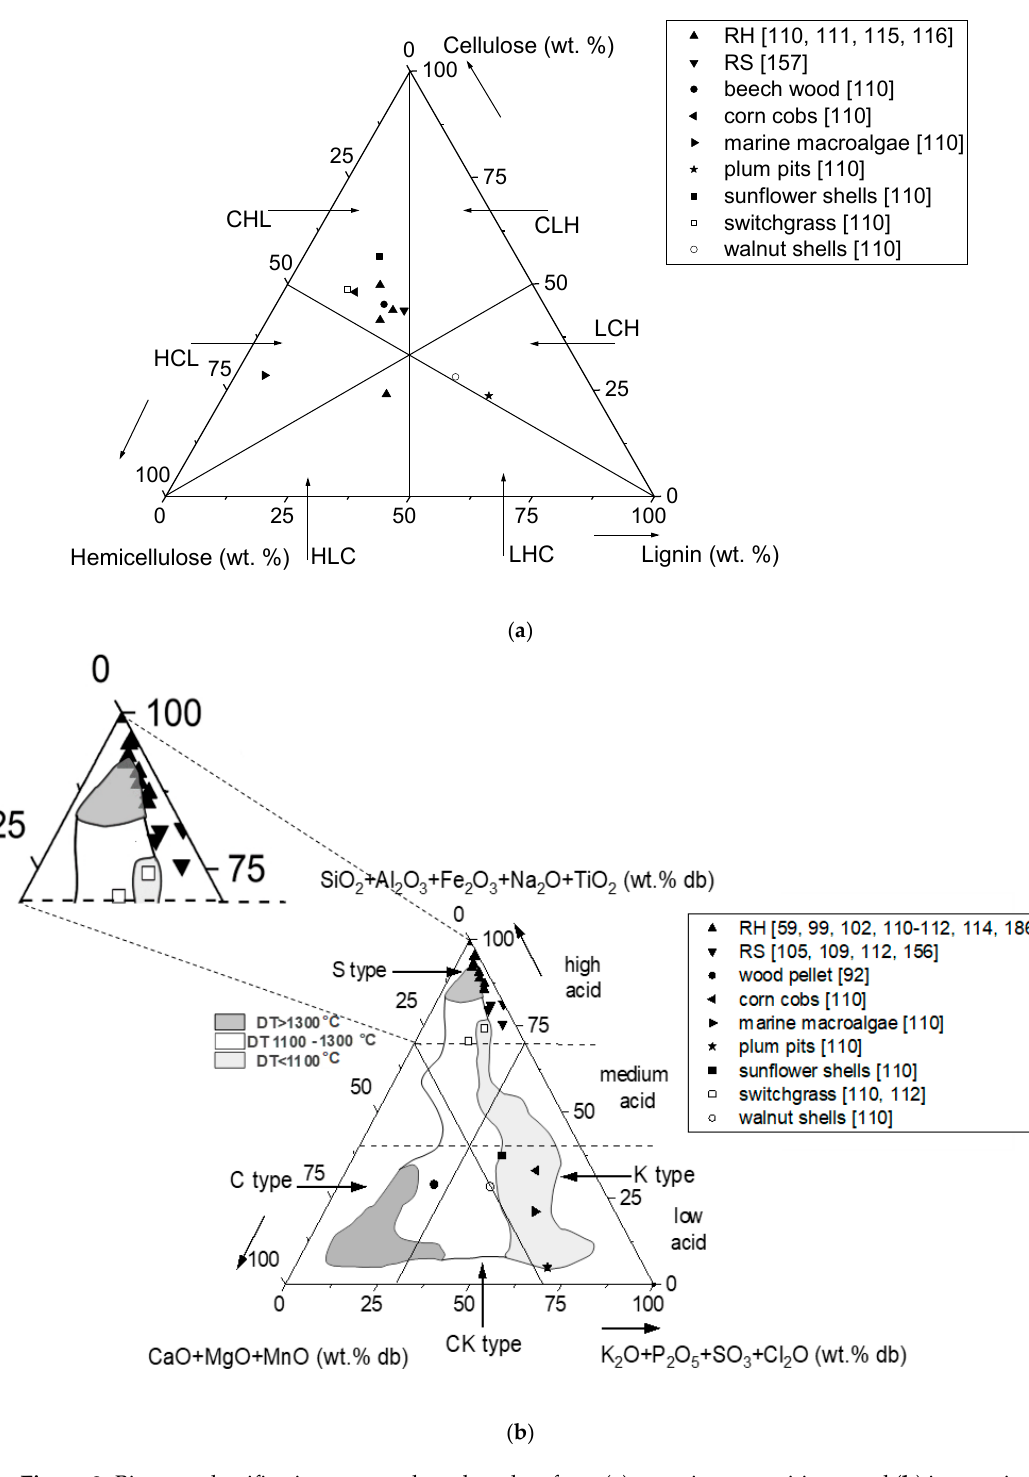
Figure 2. Biomass classification systems based on data from ( a ) organic compositions; and ( b ) inorganic composition of the fuel ash and ash melting tendency (data were taken from [59,92,99,102,105,109–112,114–116,156,157,186]).